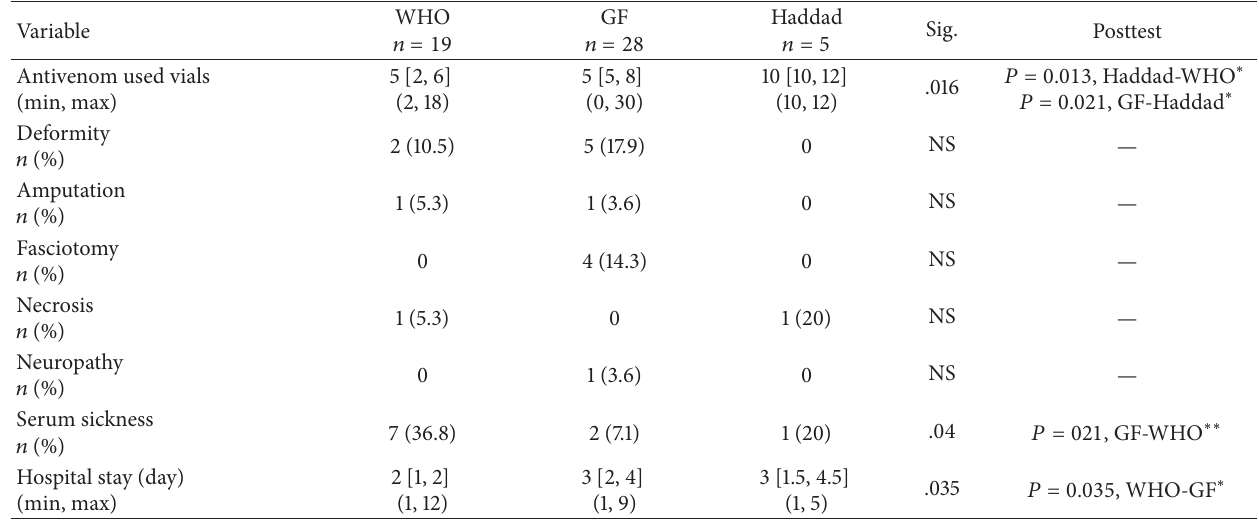
Table 2: Follow-up data on three common snakebite protocols ( 𝑛 = 52